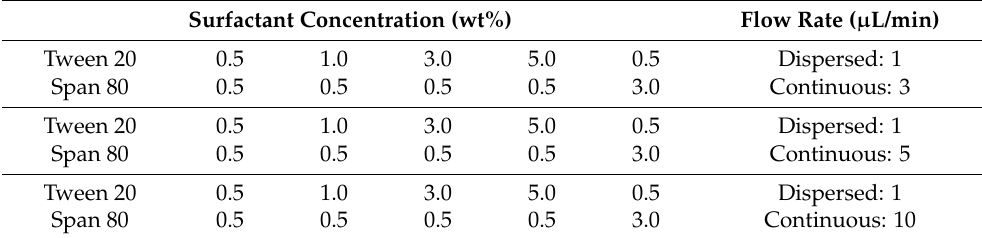
Table 1. Surfactant concentration and flow